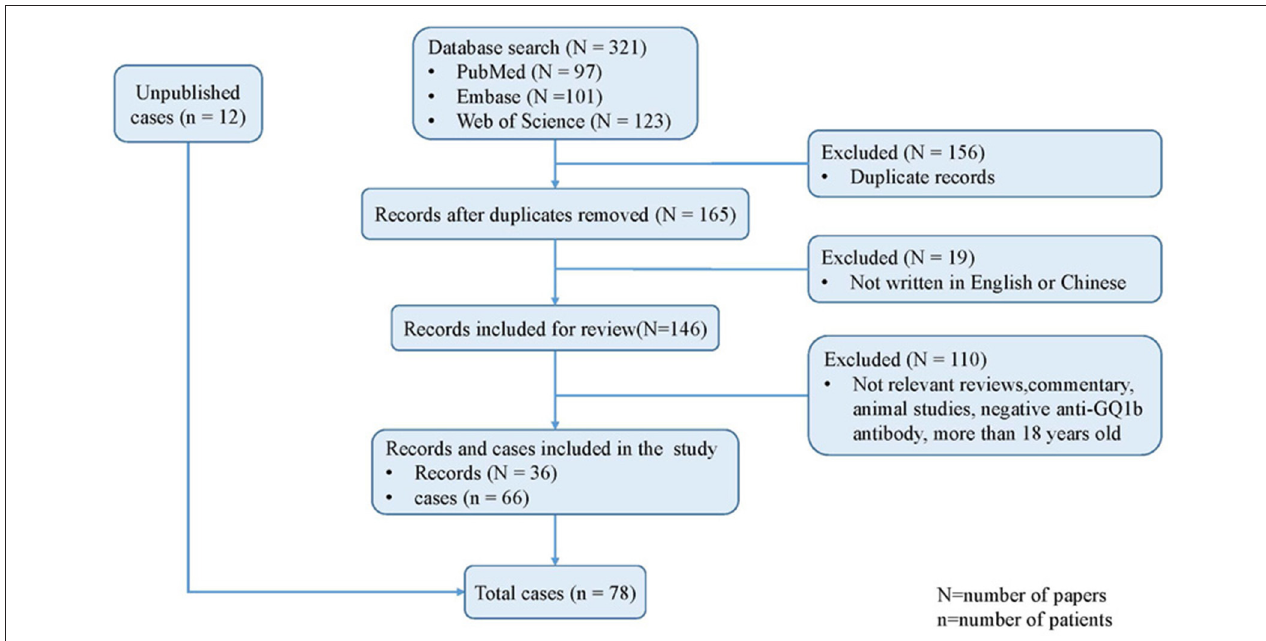
FIGURE 1 | Algorithm of systematic